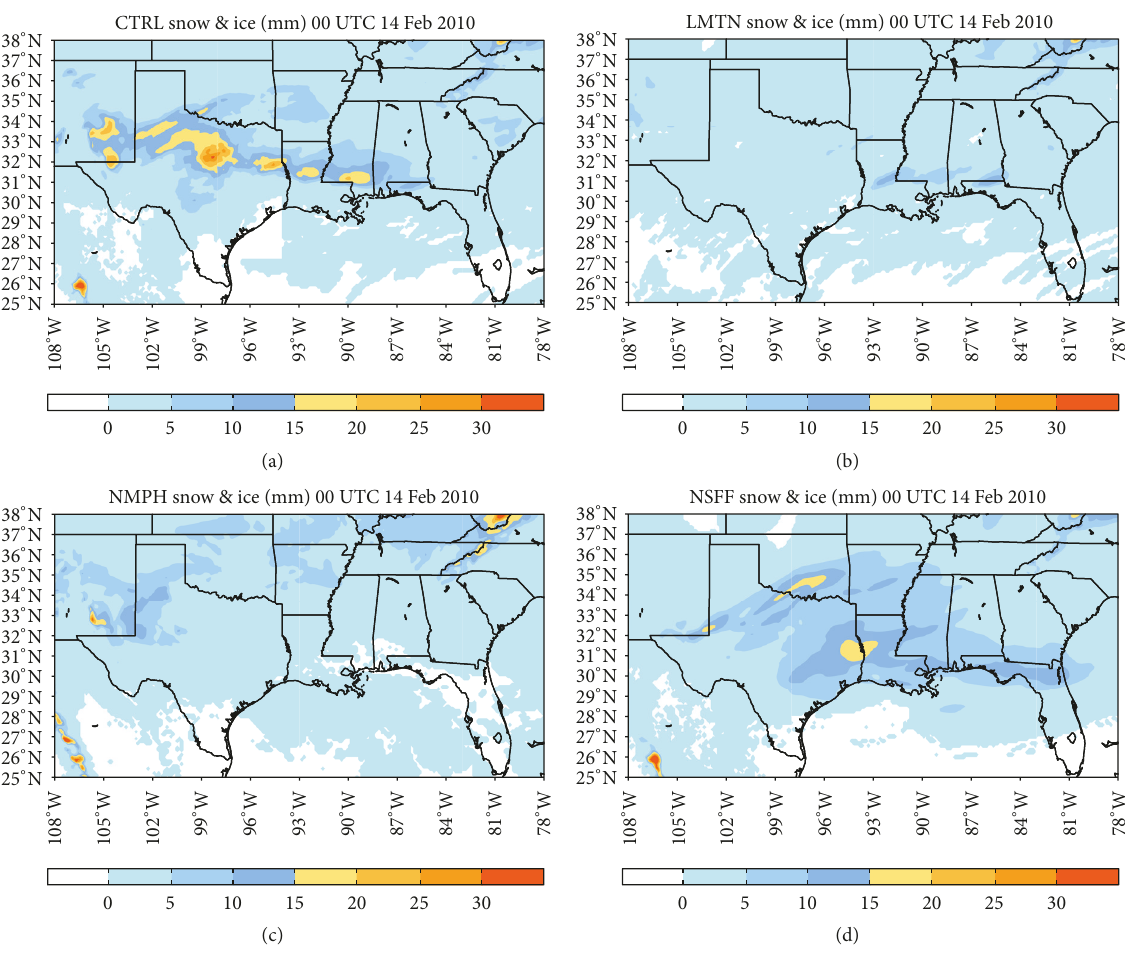
Figure 22: Simulated (12km) total snow and ice accumulation (mm) from on 0000 UTC 14 February 2010 on (a) the control experiment, (b) the terrain reduction experiment, (c) no microphysics heating experiment, and (d) no surface flux